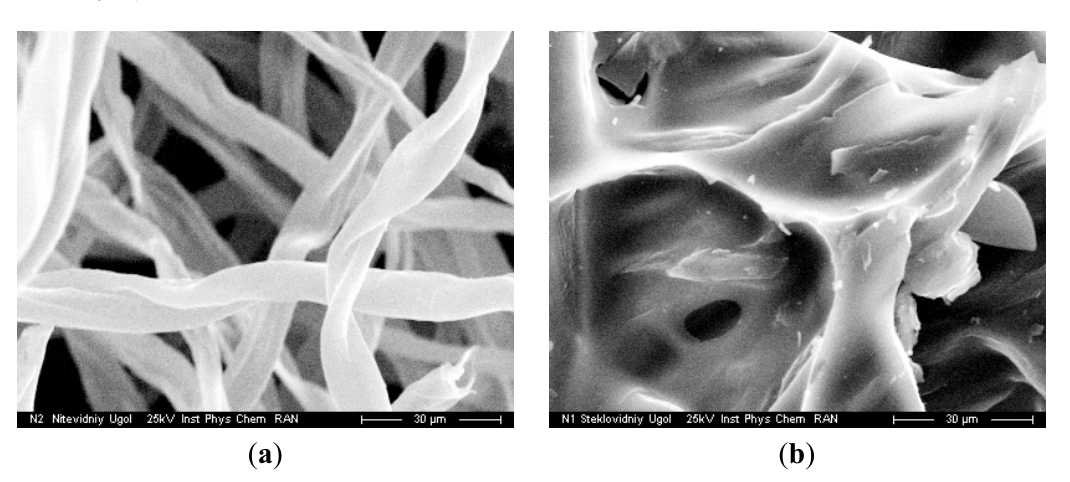
Figure 14. Photomicrographs of two structural modifications of charcoal (the scale is 105 × 80 μ m)